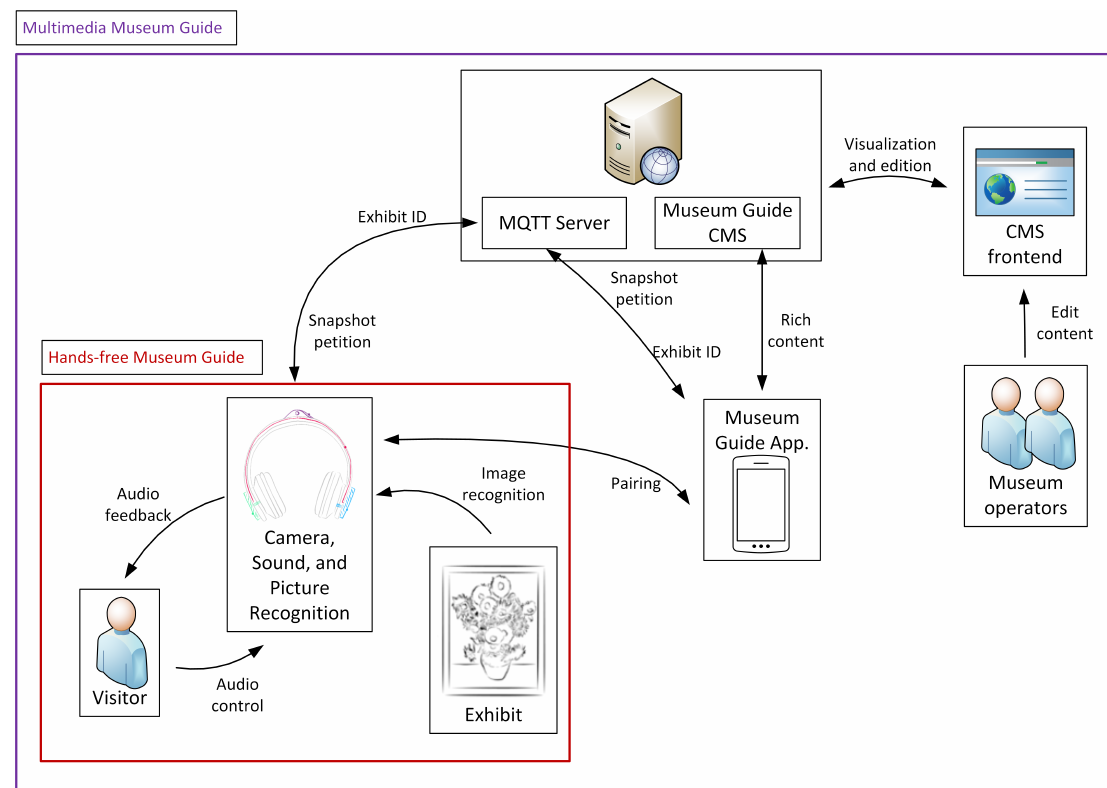
Figure 7. Architecture of the complete